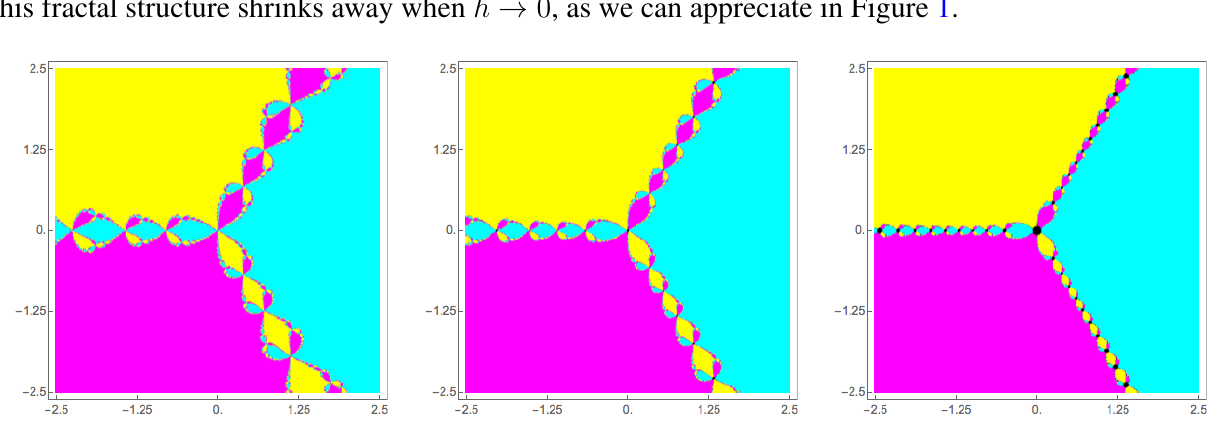
Figure 1. Basins of attraction of the relaxed Newton’s method given in Equation (1) applied to the polynomial p ( z ) = z 3 − 1 for h = 1 , h = 2 / 3 and h = 1 / 3 ,